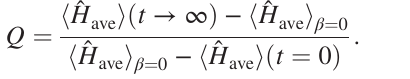
ˆ H ) ave ˆ H ϕ n i vs the ave j